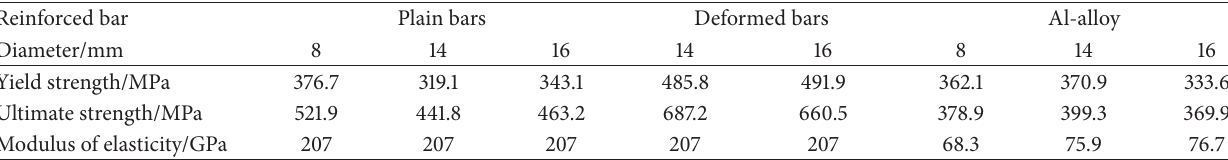
Table 1: Material